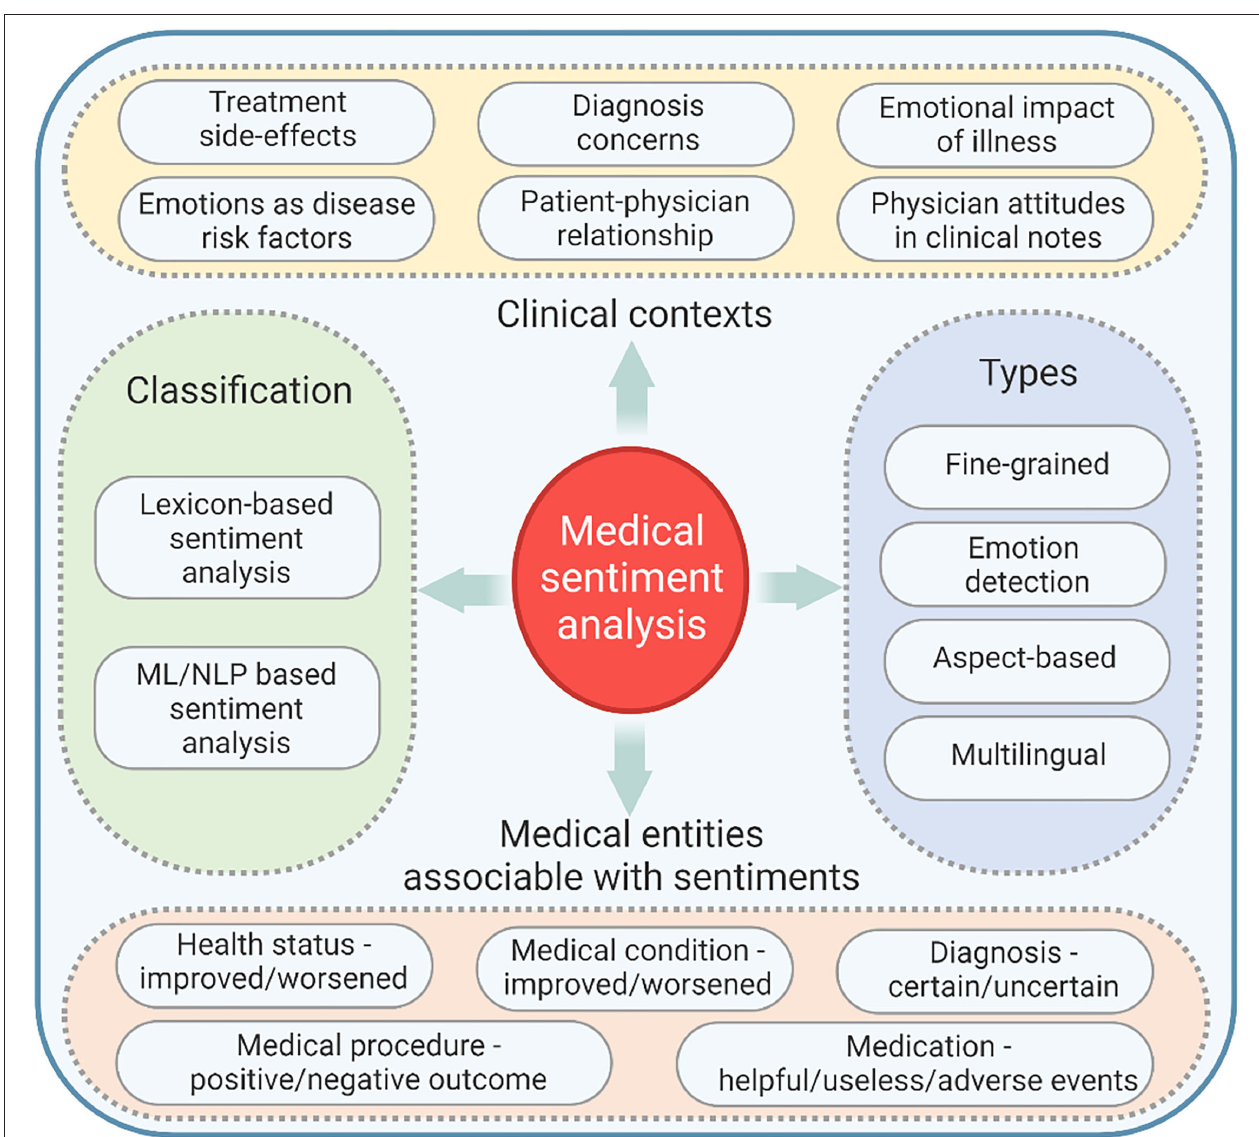
FIGURE 1 | Introductory concepts in medical SA: applicable clinical contexts, medical entities associable with sentiments, classification, and types of